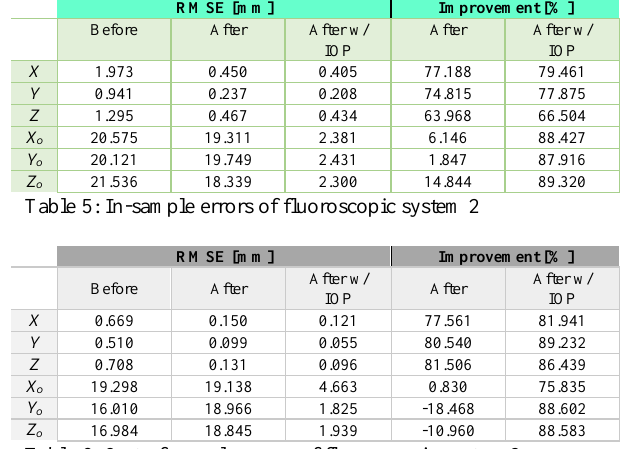
Table 6: Out-of-sample errors of fluoroscopic system 2